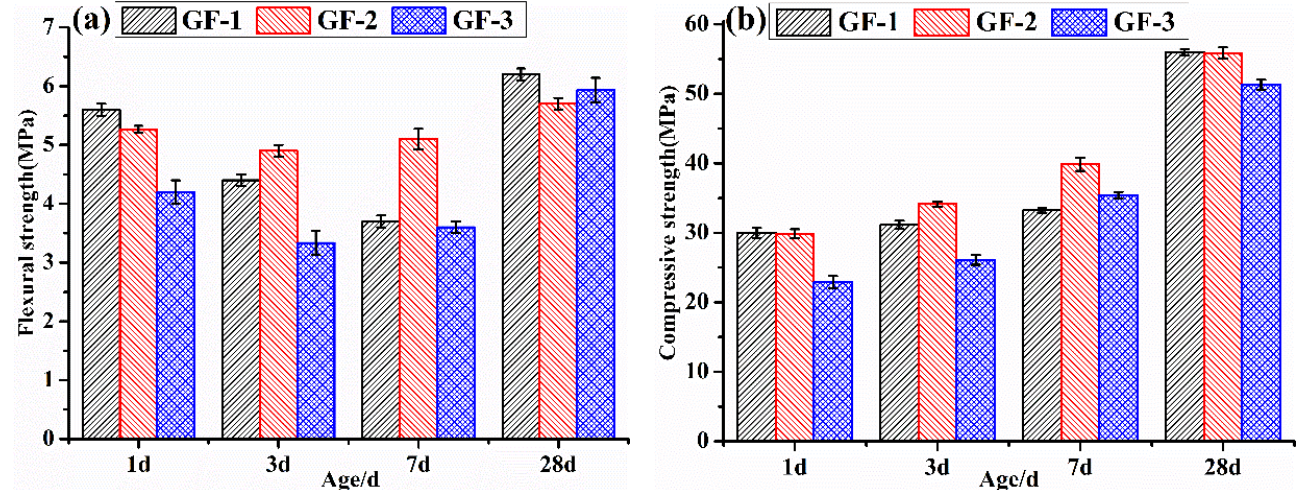
Figure 8. ( a ) The flexural and ( b ) compressive strength of the BBSC mortars.